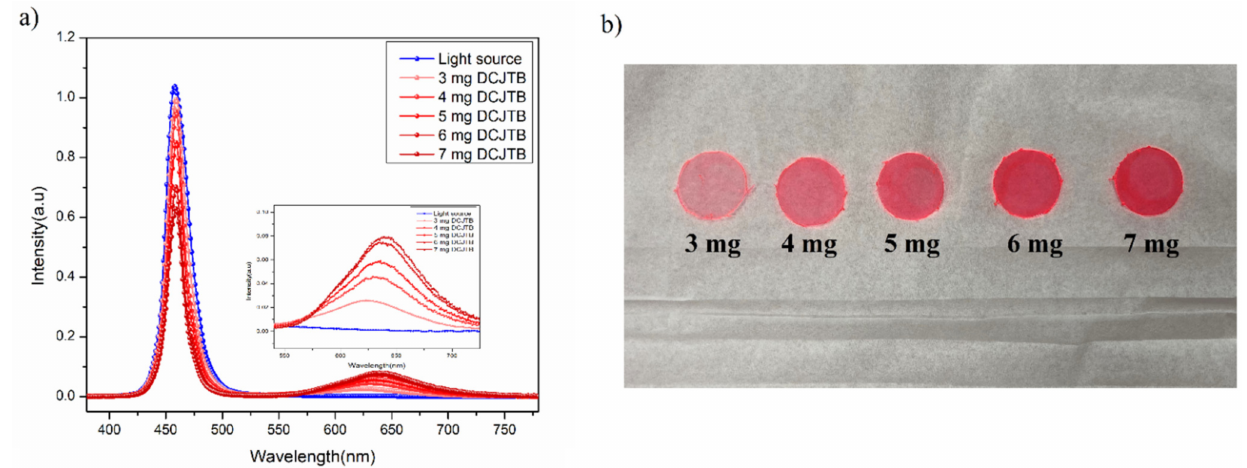
Figure 2. ( a ) Quantum yield profile of DCJTB-based fluorescent film at different concentrations and ( b ) film morphology of DCJTB at different concentrations.